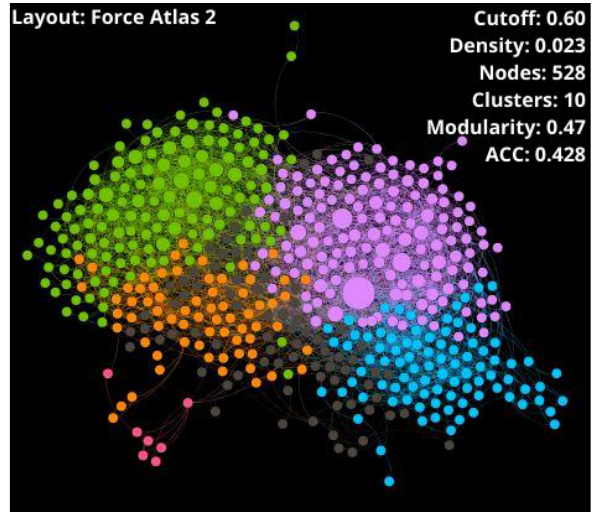
Figure 5. CSN of giant component conformed by 528 THPs retrieved from starPepDB. Node color represents the community (cluster), and node size symbolizes the centrality values.